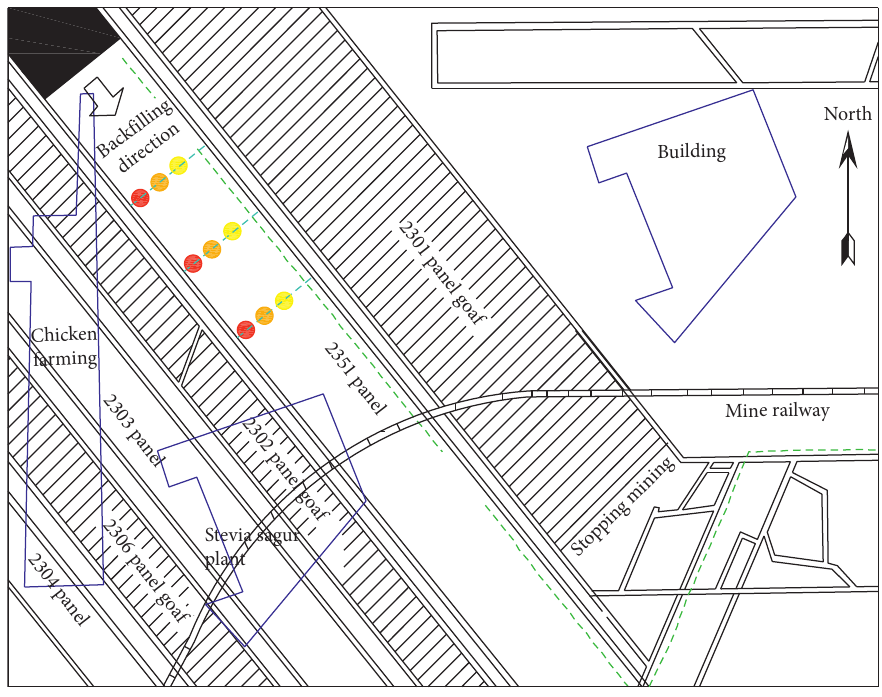
Figure 1: Distribution of coal mine filling working